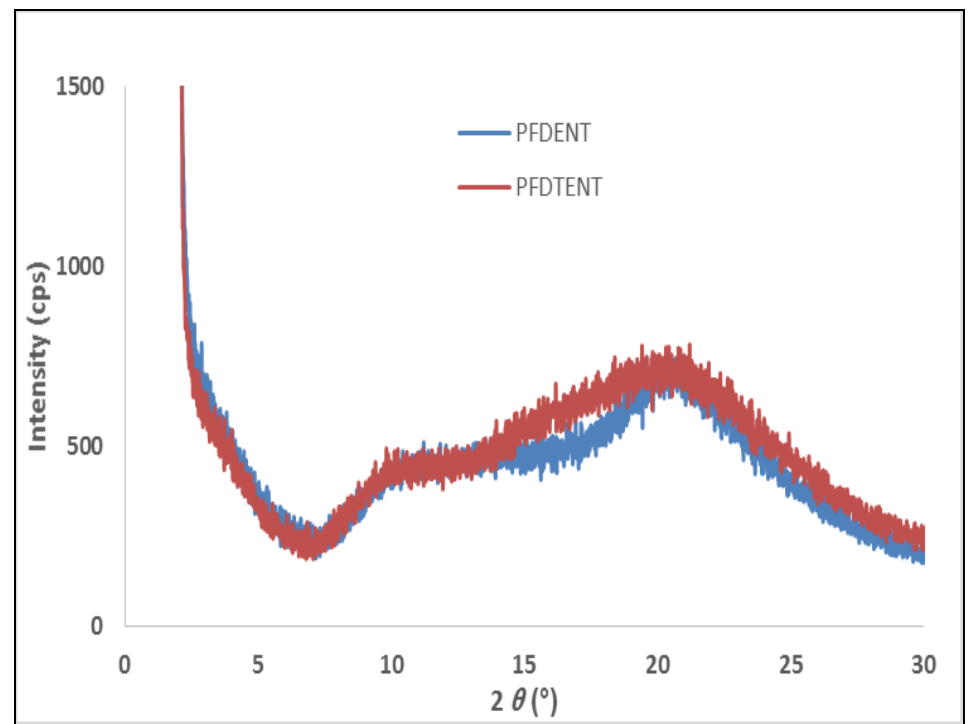
Figure 5. Powder XRD profiles of the target polymers.